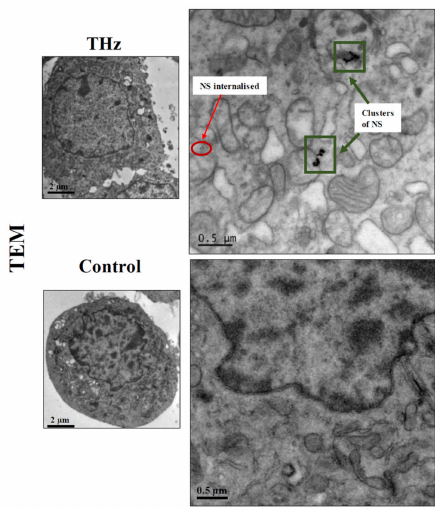
Figure 1. Nanosphere internalisation of PC 12 cells following a 10 min exposure of THz radiation. Confocal laser scanning microscopy (CLSM; top row) images illustrate the uptake of silica nanospheres (FITC) by the THz treated cells whereas the untreated control does not exhibit any nanosphere uptake. No signal was detected in the FITC channel for the untreated cells. Scale bar is 5 µ m. Thin sliced transmission electron microscopy (TEM) micrographs confirm silica nanospheres (NS) being internalised by the PC 12 cells (red arrow; bottom). Nanospheres are also seen lining the cell membrane whereas no nanosphere internalisation was observed in the untreated control cells. Scale bar is 1 µ m.